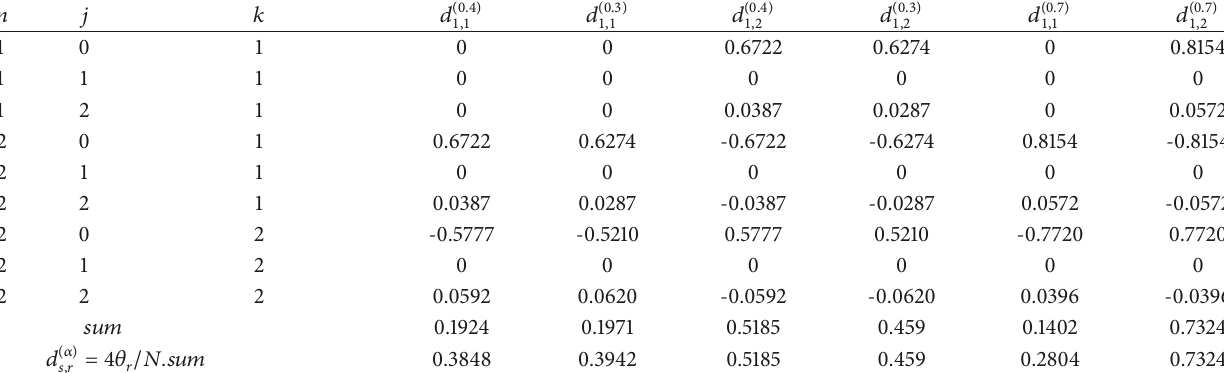
Table 1: The values of Caputo fractional derivative when ( 𝛼 = 0.4 , 𝛽 = 0.2 and 𝜇 = 0.1 in Case 1) and ( 𝛼 = 0.7, 𝛽 = 0.4 𝑎𝑛𝑑 𝜇 = 0.3 in Case 2 needed later on) are shown.